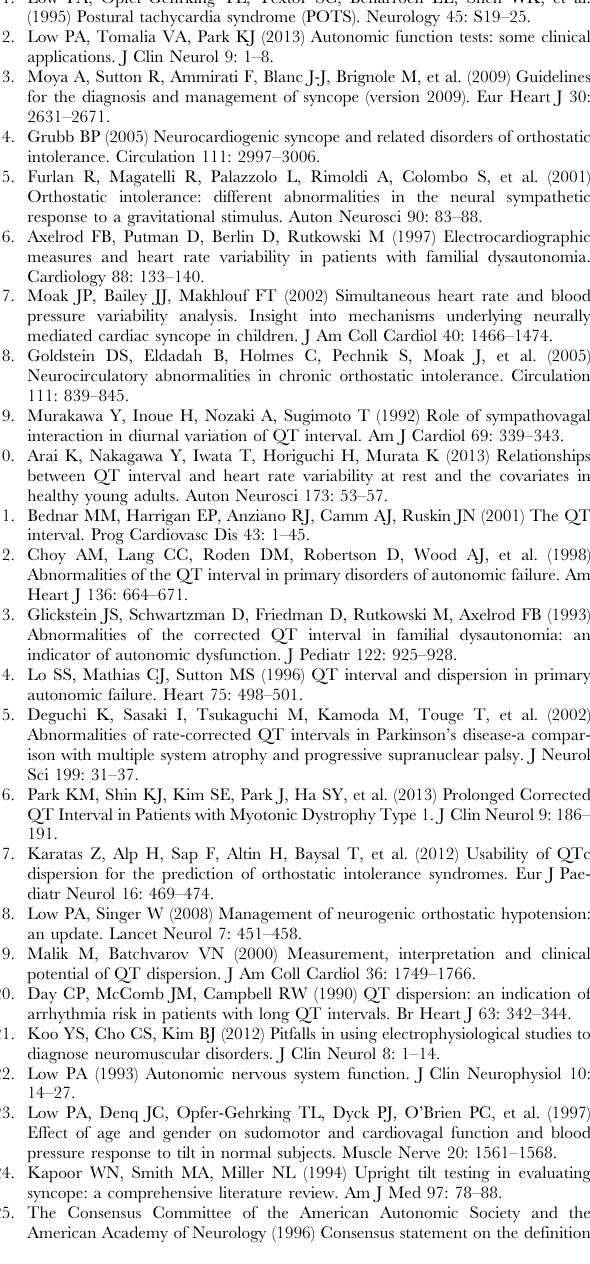
table testing. Pacing Clin Electrophysiol 20: 2205–2212. 28. Bradbury S, Eggleston C (1925) Postural hypotension: a report of three